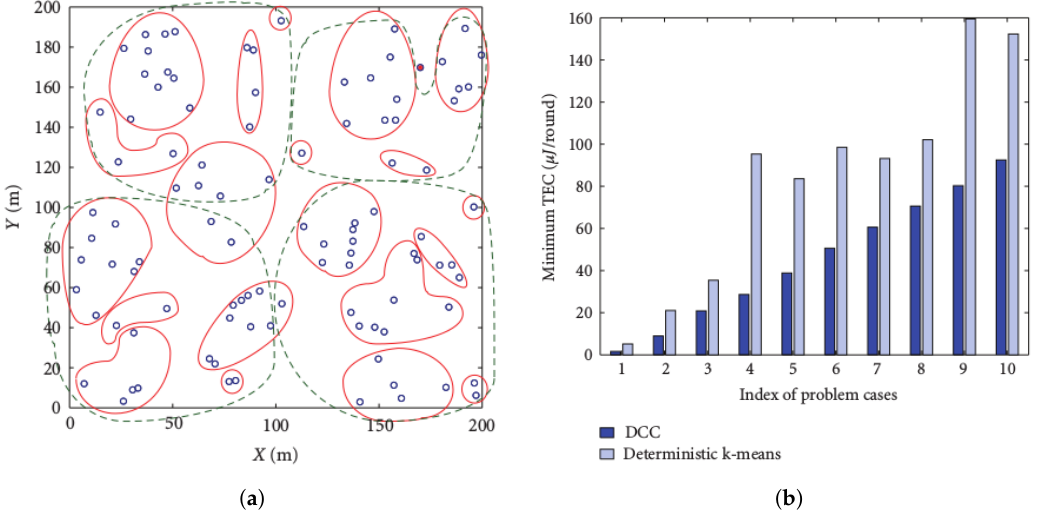
Figure 1. Comparison between Distance-based Crowdedness Clustering (DCC) and deterministic k-means [6]. ( a ) Clustered nodes; ( b ) minimum energy per round. TEC, Total Energy